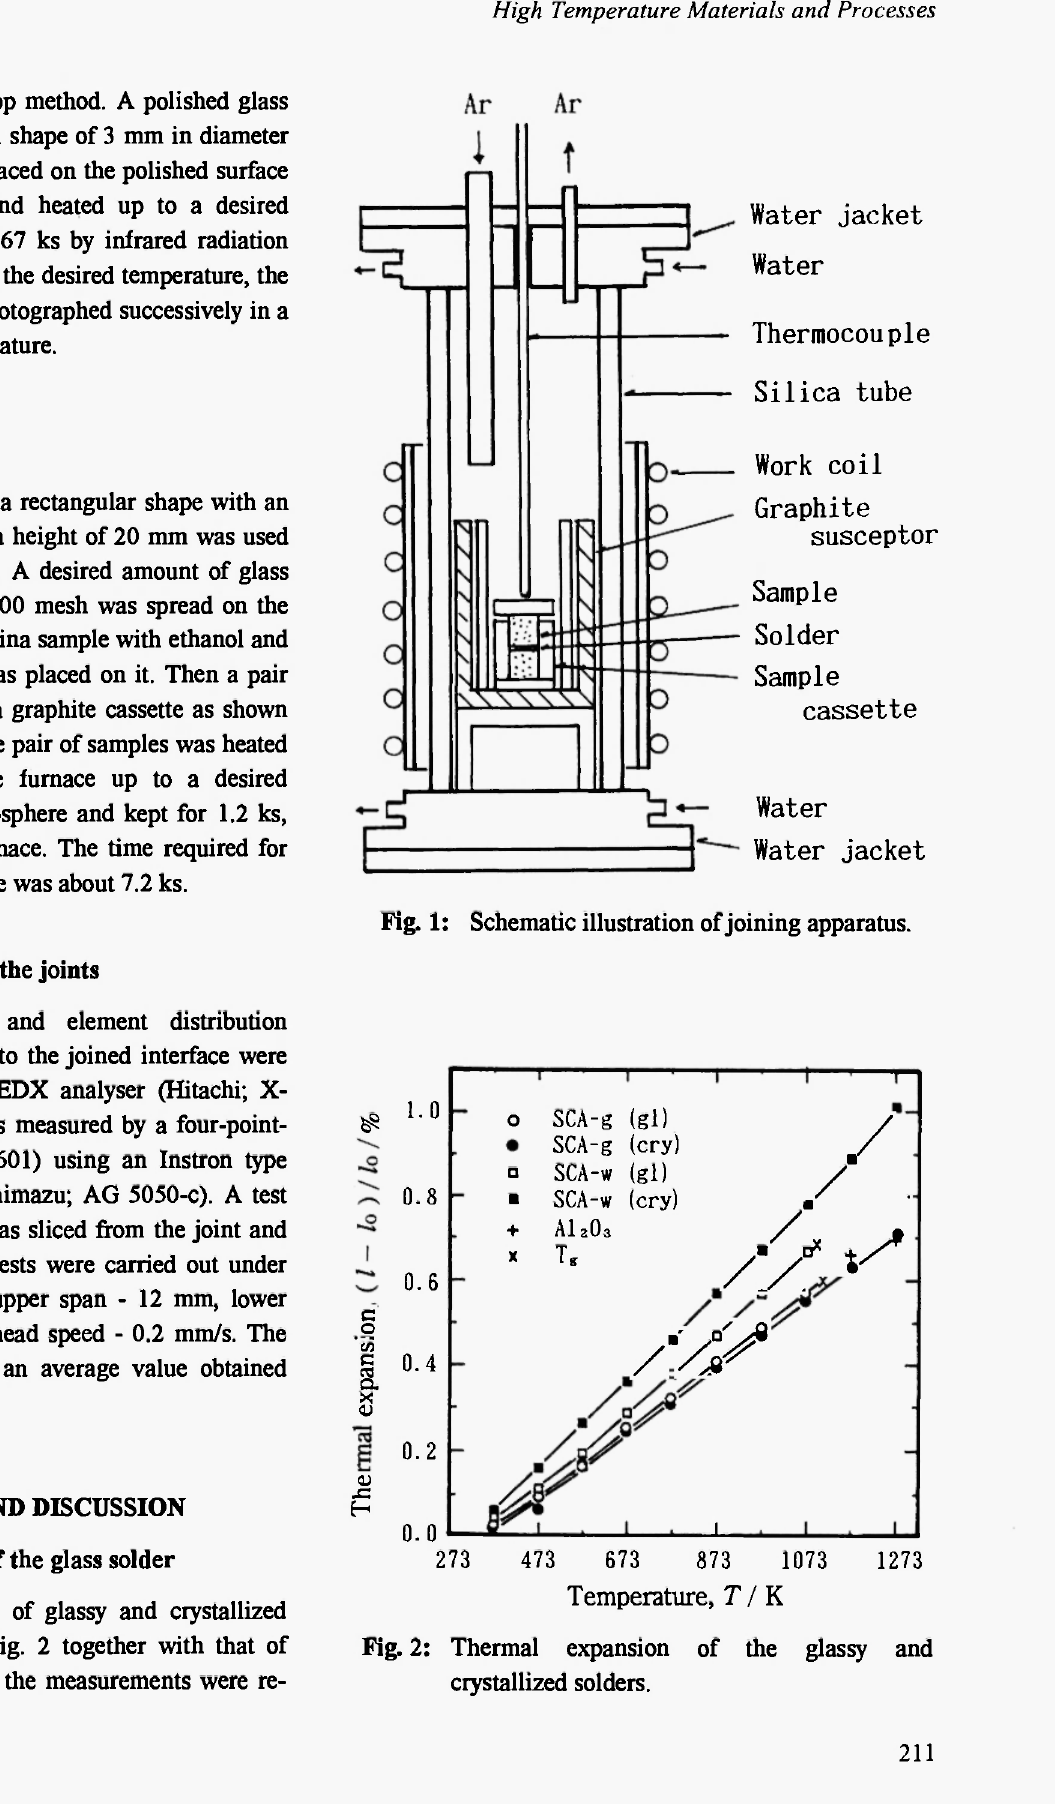
Fig. 2: Thermal expansion of the glassy